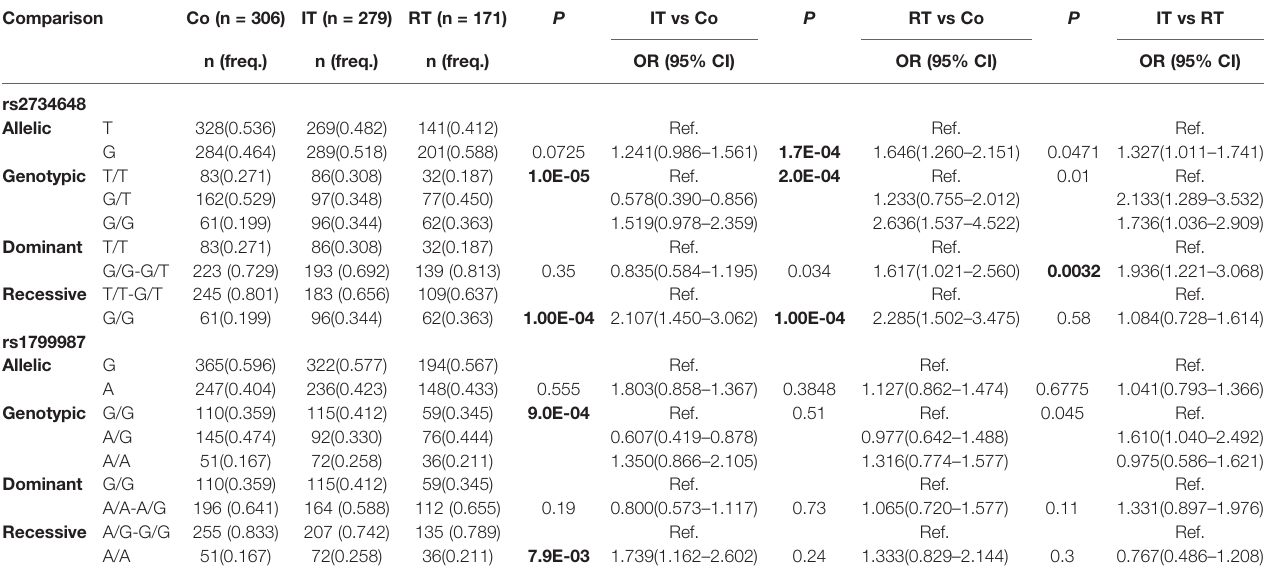
TABLE 4 | Association between CCR5 gene variants and TB recurrence. Comparison